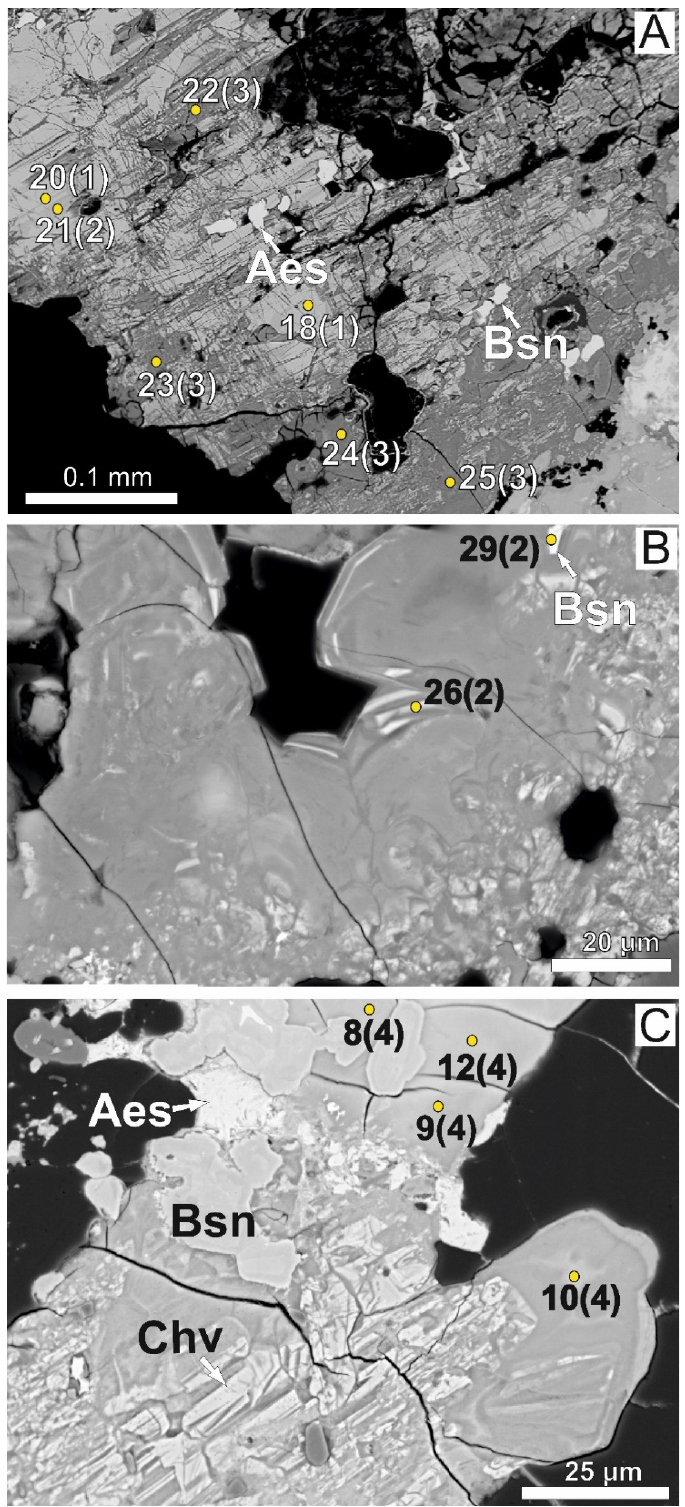
Figure 2. BSE images of textural relationships between Groups. ( A ) Striped zone consists of linear strips and small patches of Groups 1 and 2. Group 3 forms dark grey areas (e.g., bottom right), containing pale remnants of Groups 1 and 2. Spots show group and analysis number in Tables 1 and 2. ( B ) The main, pale grey area is Group 3, containing multiple remnants of Group 2. ( C ) Striped area (bottom left) breaks up to the right and eventually forms the pale “pseudo-homogeneous” grey areas (Group 4). Aes, aeschynite-(Y), Bsn,